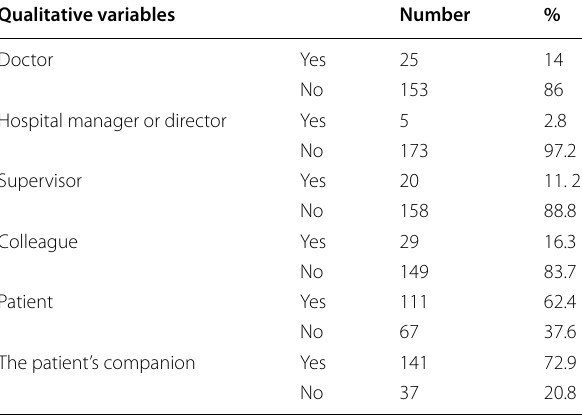
Table 3 Frequency distribution of the person who caused the violence in the population under study